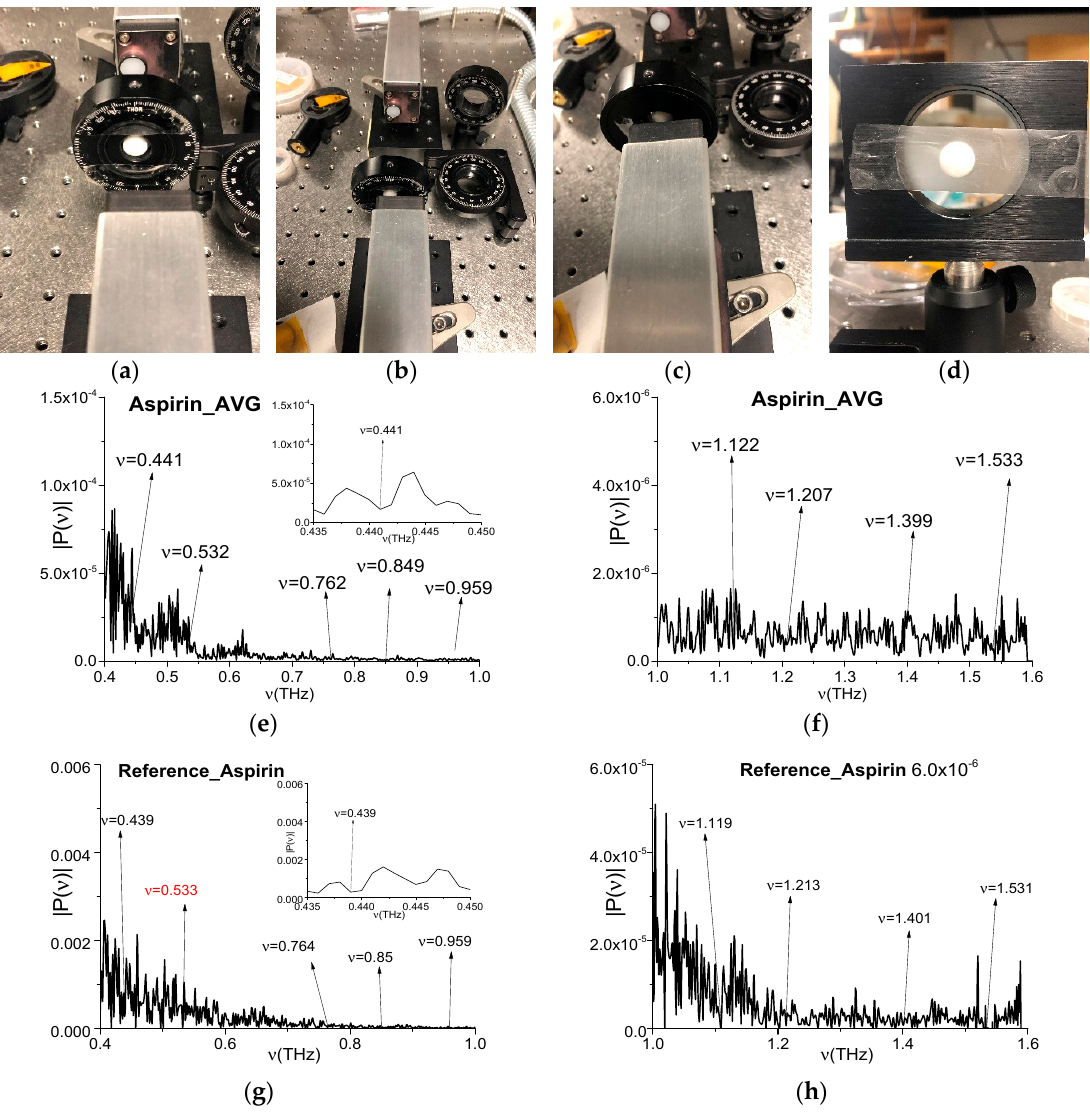
Figure 13. Aspirin pellet in the THz spectrometer ( a – d ), Aspirin_AVG spectra ( e,f ) and reference spectra ( g,h ) in the frequency ranges ν = [0.4, 1.0] THz ( e,g ) and [1.0, 1.6] THz ( f,h ) .